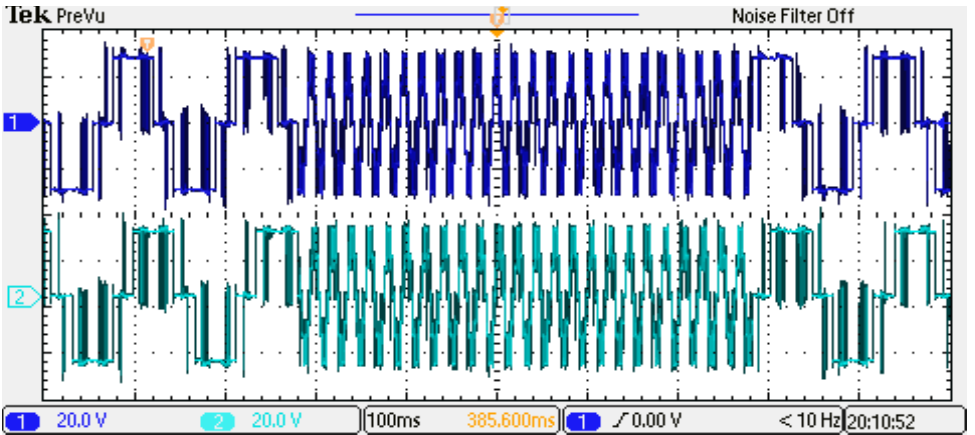
Figure 21. The whole conversion process of the modulation strategy.